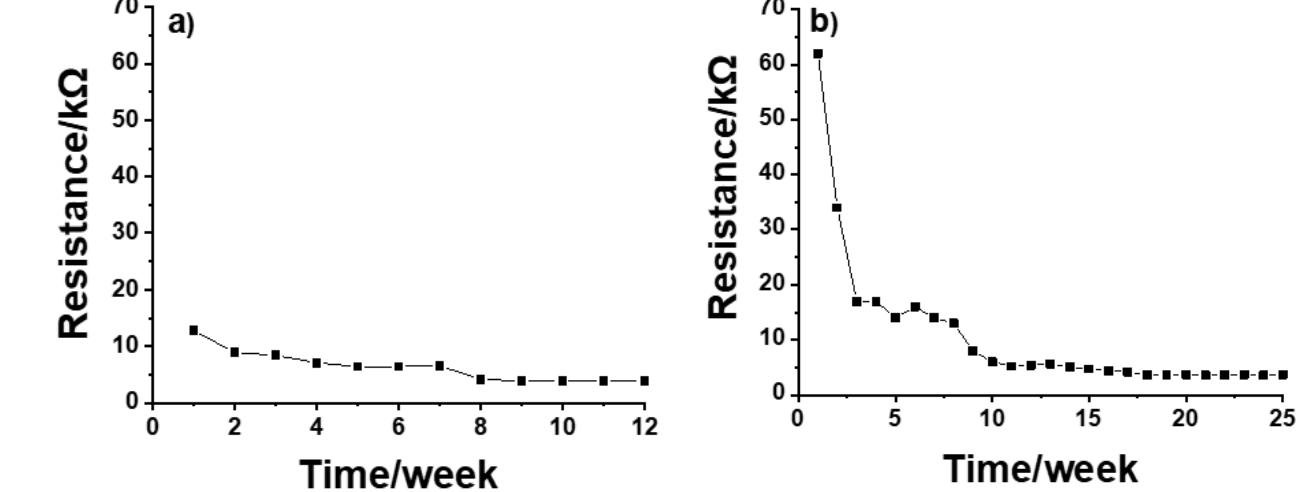
Figure 4. Resistance values of ( a ) CP SSC and ( b ) IM SSC reference electrodes measured during the conditioning process.